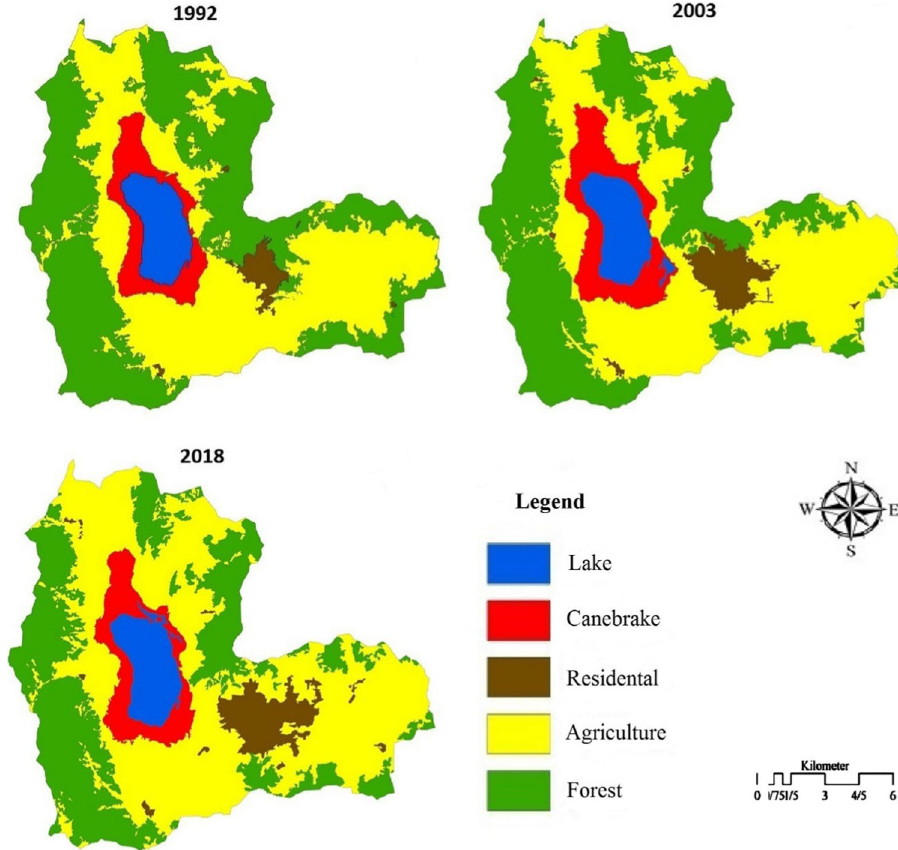
Fig. 3 Land-use types of the study